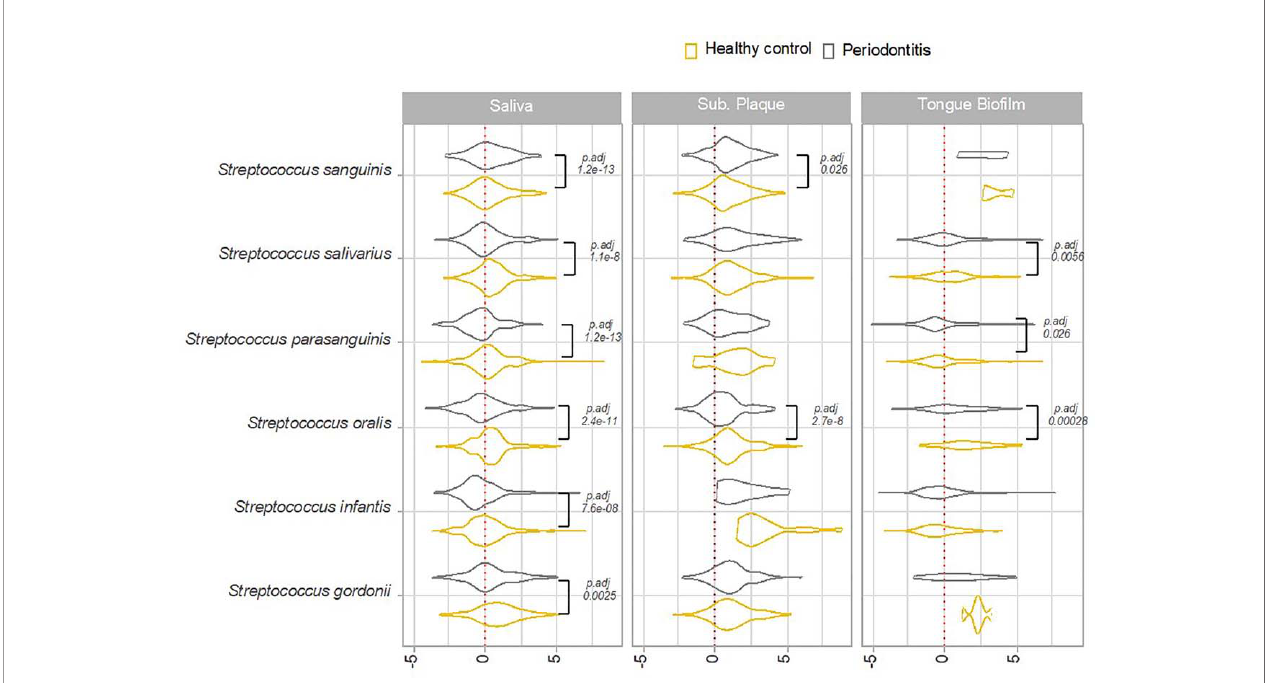
FIGURE 5 | Overall transcriptional activity of Streptococcus species in oral health versus periodontitis. Transcriptional activity of predominant Streptococcus species in periodontitis versus oral health, as evaluated by log2(RNA/DNA), with each dot representing a speci fi c pathway. Color coding: yellow: healthy control, grey: